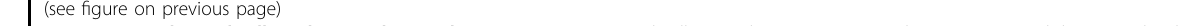
Fig. 4 CD44 enhanced cell rigidity via RhoA and Rac1. a CD44 promoted cell internalization. Orange and gray represented the internalized cells with relatively high and low CD44 expression, respectively. EV: empty vector, NC: non related control. Data are means ± SD of more than three images of 20× objective. n > 59/each. b Representative images showing homotypic CIC structures with CD44-high cells internalized (in red and green, respectively). Scale bar, 20 µm. c CD44 positively regulated the expression of RhoA and pMLC in PLC/PRF/5 isogenic cells. d Time-lapse images in x – z plane for the deformation of PLC/PRF/5 isogenic cells compressed by agarose gel. e , f CD44 regulated cellular deformation dynamics over time ( e ), or in response to different weight loads (nN) ( f ) as determined by agarose compression assay. Data are means ± SD of triplicate experiments. g CD44 enhanced cell rigidity via RhoA and Rac1 as determined by agarose compression assay. Data are means ± SD of triplicate experiments. h The siRNA- mediated knockdown of Rac1 and RhoA in A4S and F6ft cells, respectively. i Formation of heCIC structures were inhibited, or promoted by knocking down Rac1 or RhoA, respectively, in PLC/PRF/5 isogenic cells. Data are means ± SD of more than three images of 20× objective. n > 300 cells analyzed for each clone. * P < 0.05; *** P < 0.001. j Overexpression of RhoA and Rac1in A4S and F6ft cells, respectively. k Formation of heCIC structures were inhibited, or promoted by overexpressing RhoA or Rac1, respectively, in PLC/PRF/5 isogenic cells. Data are means ± SD of more than three images of 20× objective. n > 300 cells analyzed for each clone. *** P <